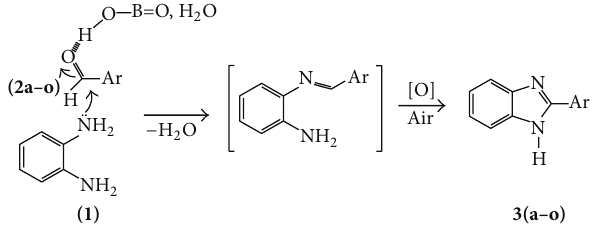
Figure 1: Plausible mechanism for the formation of